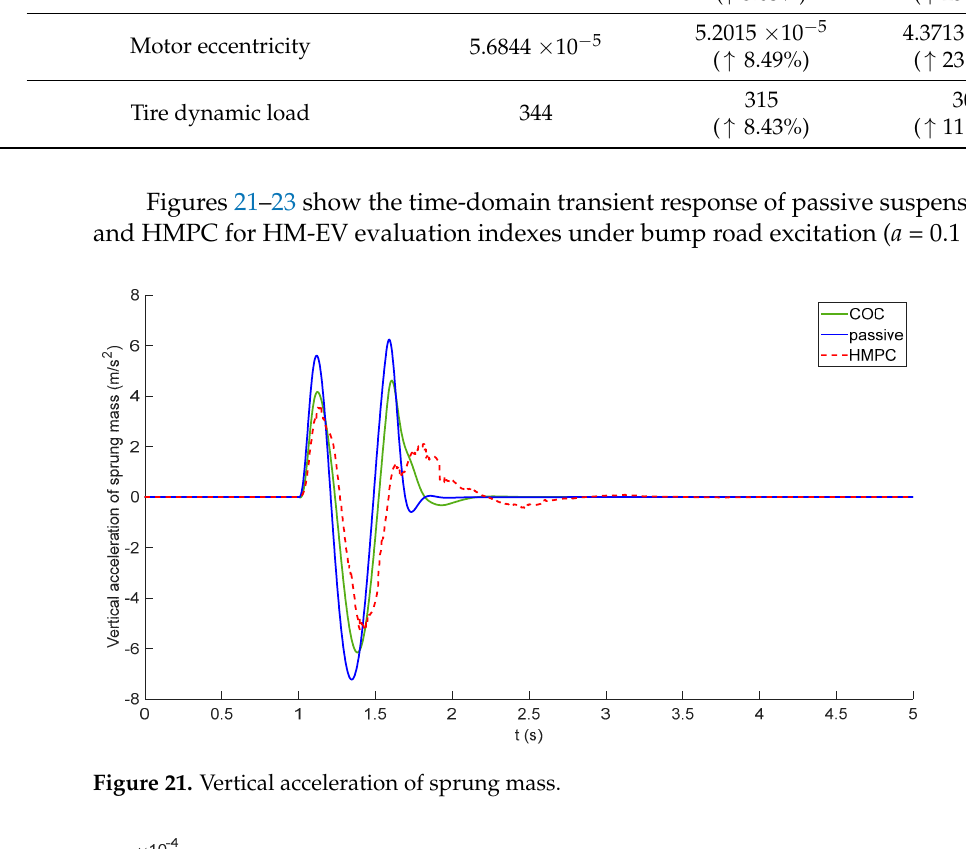
Figure 23. Tire dynamic load. In order to better compare the effect of different control methods, peak-to-peak (PTP) values were defined which represent the maximum values minus the minimum values. Table 4 shows the PTP values of each evaluation index under two types of bump road excitation.